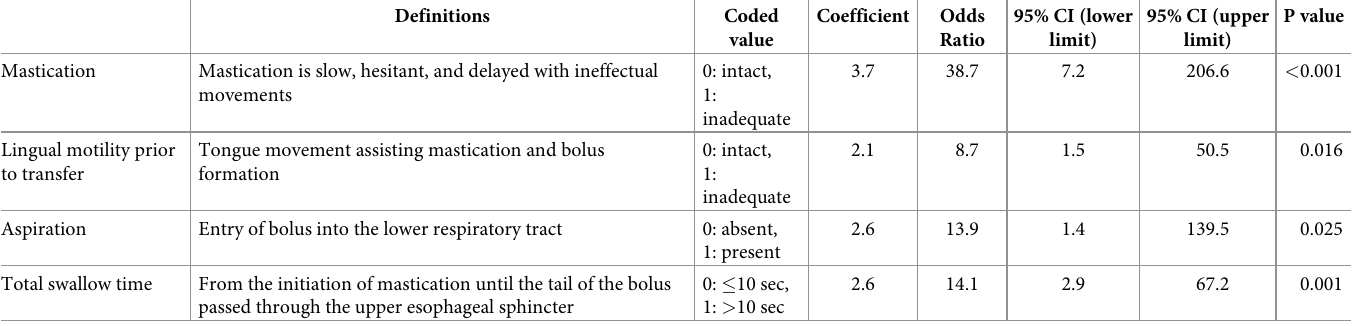
Table 3. Multiple logistic regression